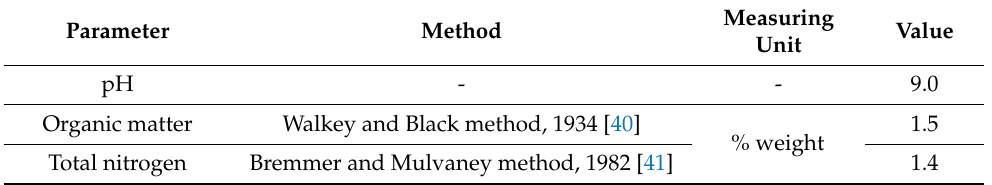
Measuring Value Unit